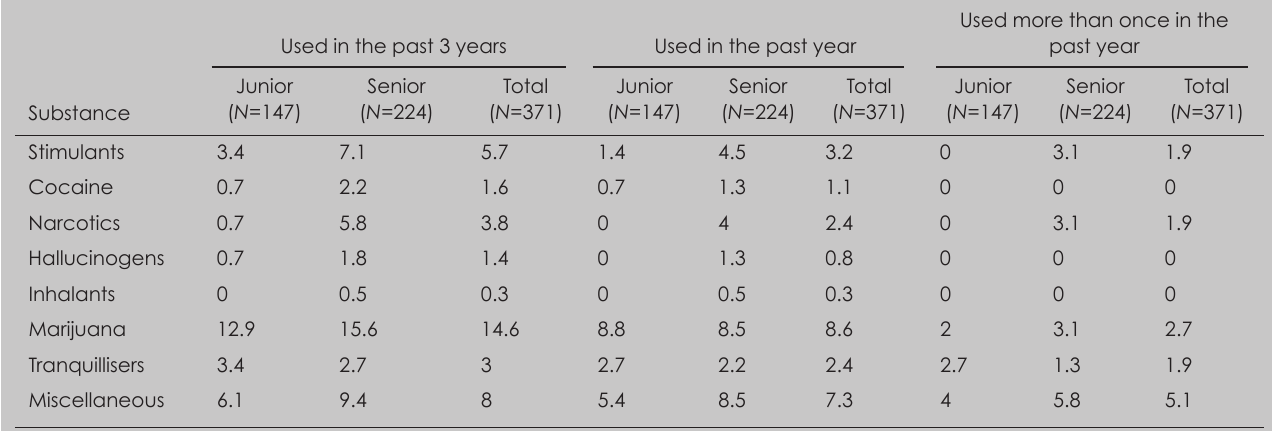
Table IV. Students using non-alcoholic substances in the past year or 3 years